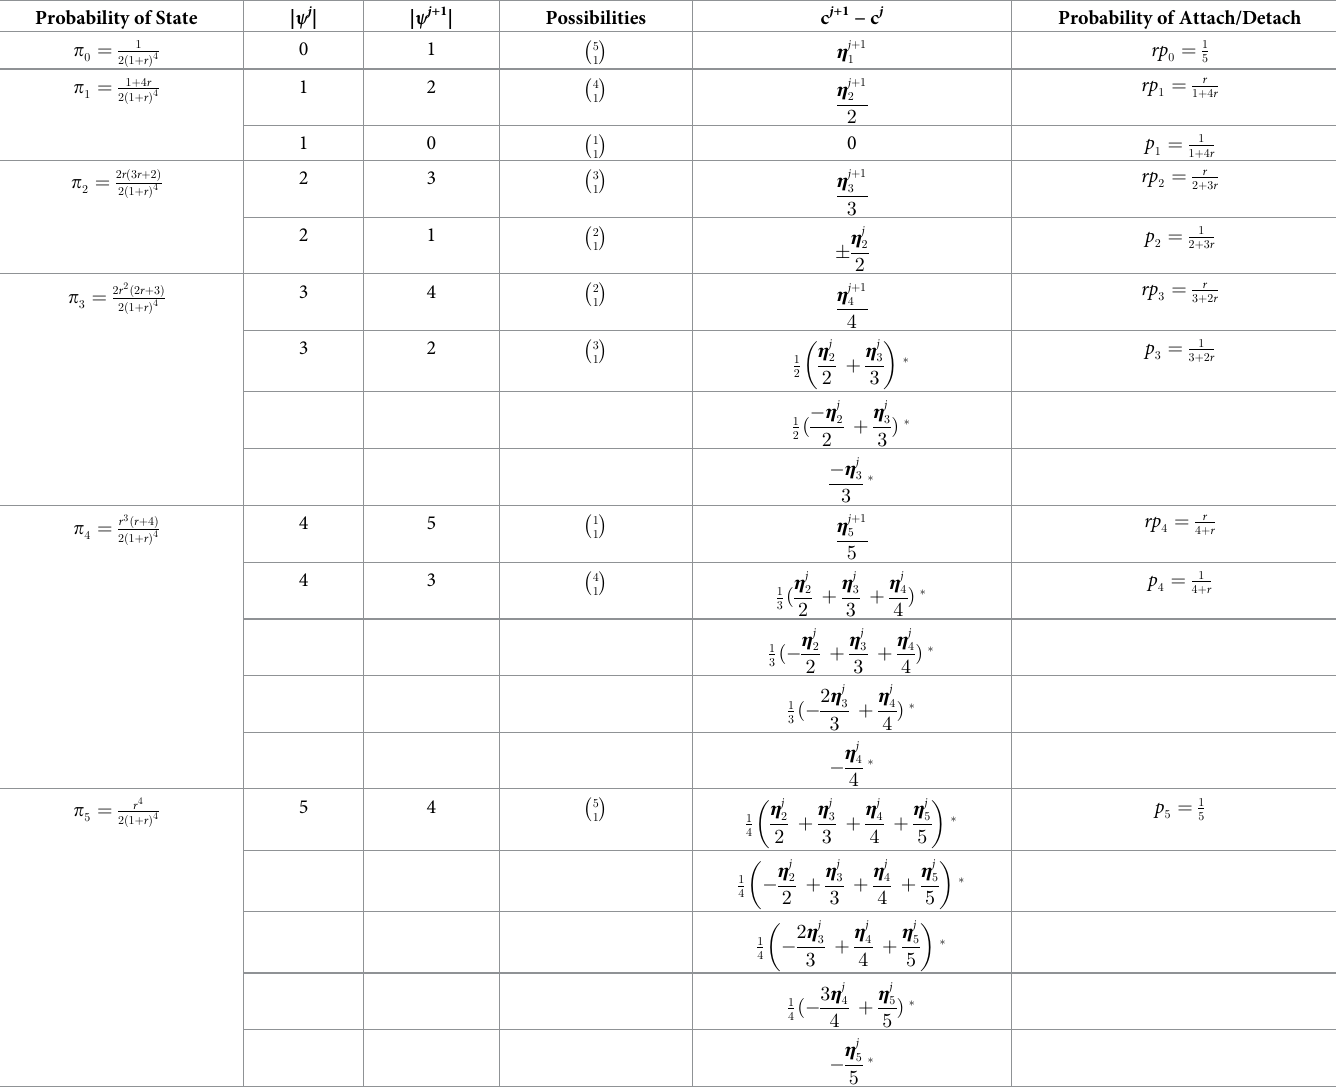
Table 2. Centroid model (n =